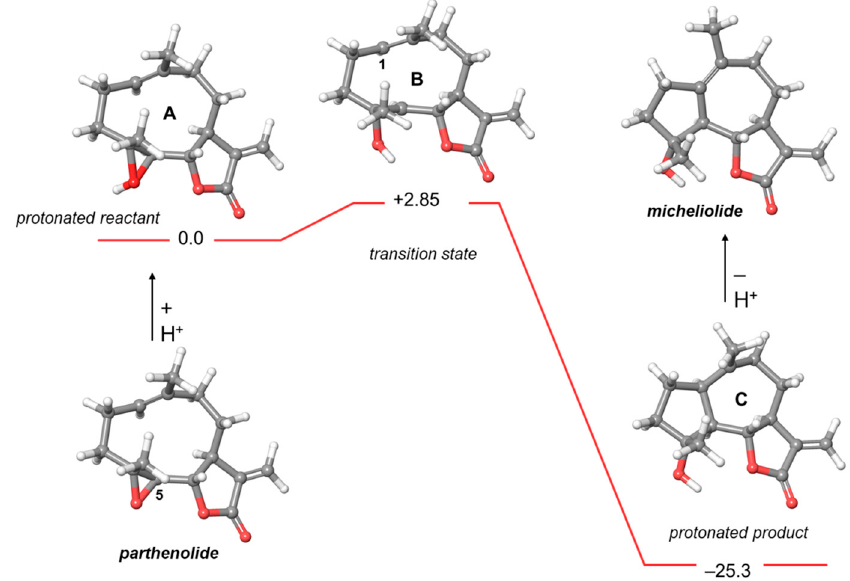
Figure 3. Energy profile of the transformation of parthenolide into micheliolide. Relative energies are reported in kcal/mol. Figure 1. Energy profile of the transformation of 2 into 5 . Relative energies are reported in kcal/mol. The hydrogen bonding interaction O-3…H-6 is represented with a dashed line.